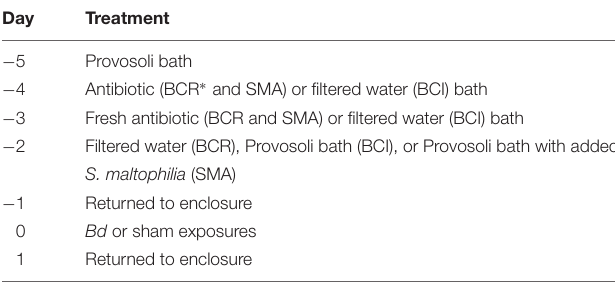
TABLE 2 | Summary timeline for bacterial manipulations.